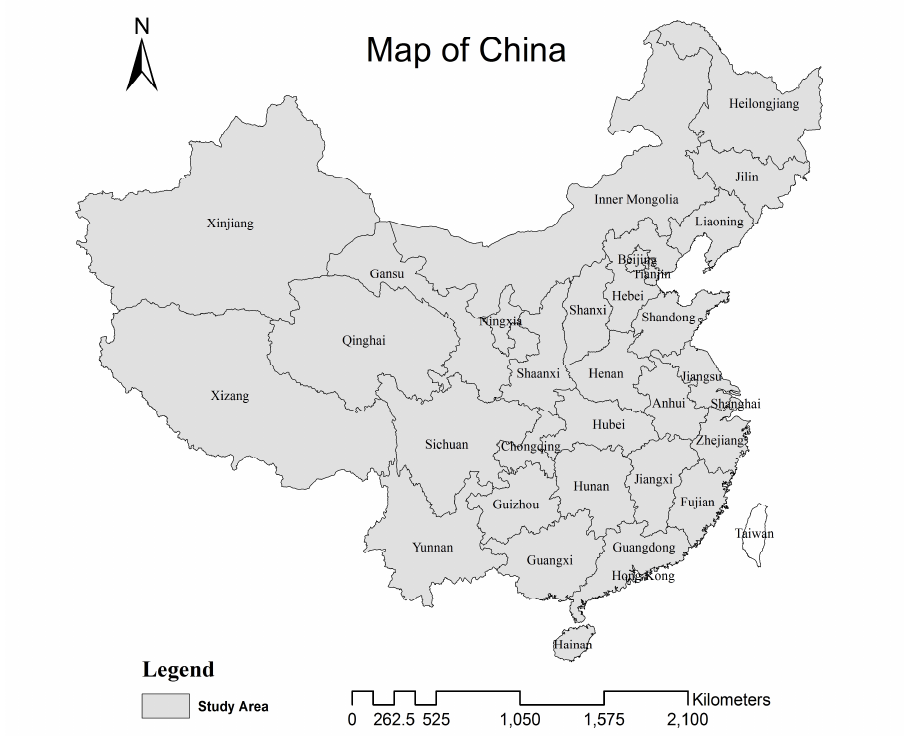
Figure 1. Map of the study area—31 provinces/municipalities in China.